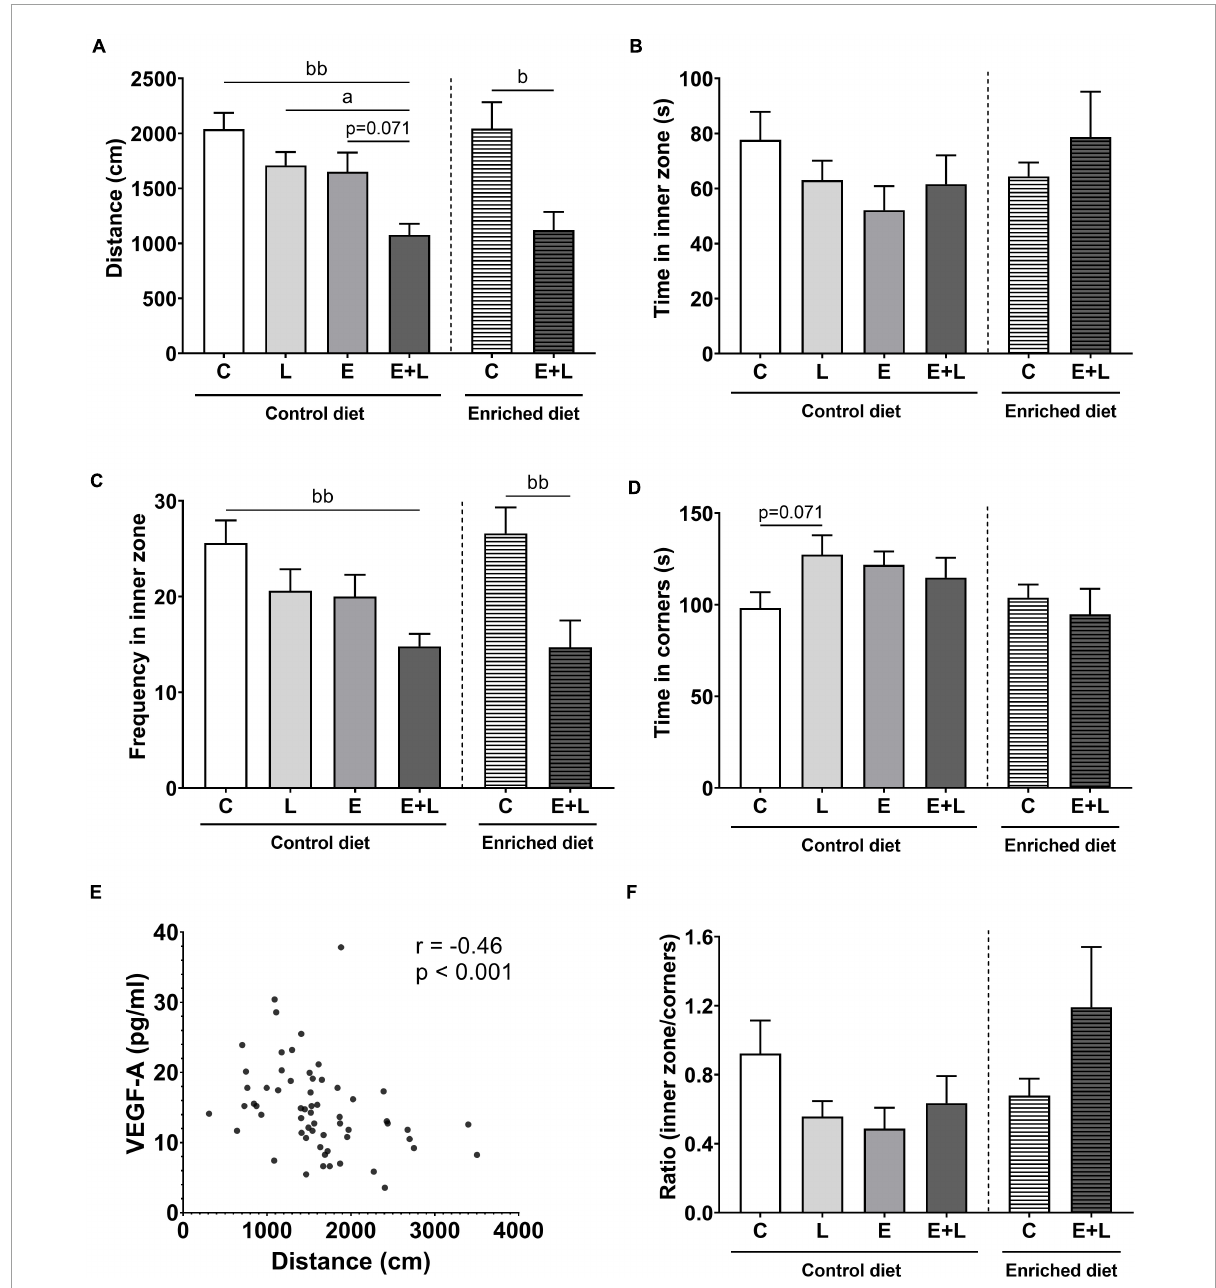
FIGURE7 Open field behavior at the end of the study on day 55 (T2). The distance walked (A) , time spent in the inner zone (B) , frequency of entering the inner zone (C) , time spent in the corners (D) and the ratio of time spent in the inner zone to time spent in the corners (F) of the open field were measured. (E) Correlation between distance walked in the open field and VEGF-A levels in serum. Data are expressed as mean ± SEM ( n = 10 per group). a p < 0.05 (first analysis for elastase and/or LPS effects). b p < 0.05; bb p < 0.01 (second analysis for diet and/or E + L effects). C, control; L, LPS; E, elastase; E + L, elastase plus LPS.